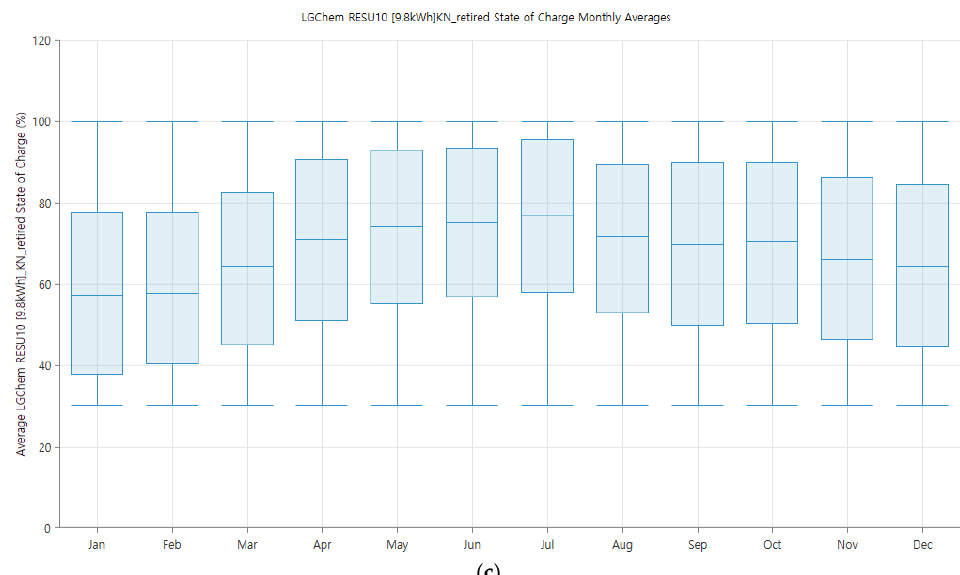
Figure 5. Monthly BESS operation (state of charge, SOC) trend (%) in ( a ) the Philippines, ( b ) Indonesia, and ( c ) Vietnam. Table 13. LCOE comparison with diesel consumption at optimal average daily load.